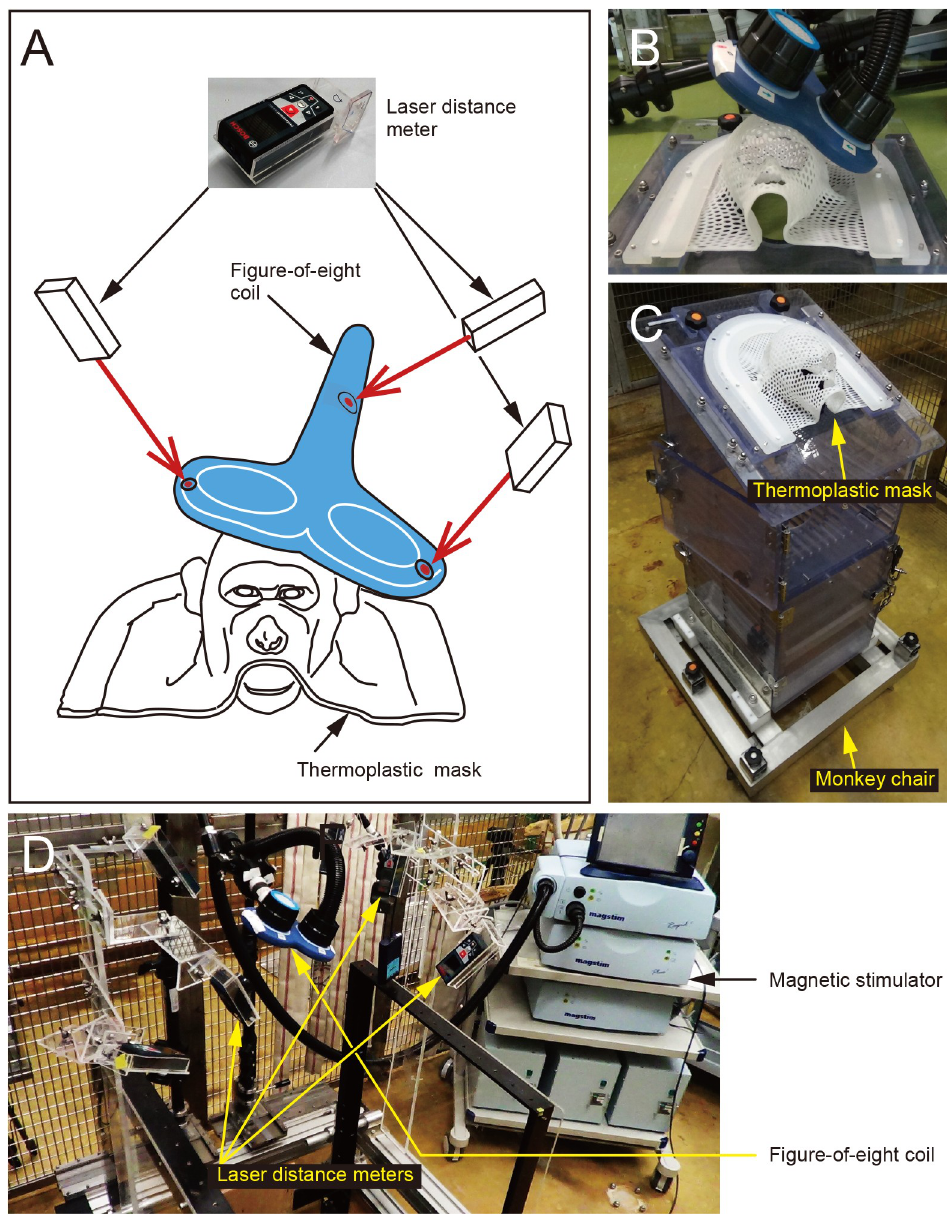
Fig 2. Setup of the newly developed rTMS system. (A) Schematic diagram of the present system for achieving constant and effective stimulation targeting the MI of an awake monkey. (B) A thermoplastic mask shaped to fit the monkey’s head is utilized to fix the monkey’s head, secure a sufficient space for a figure-of-eight coil, and contact the coil close to the scalp. (C) The thermoplastic mask is firmly screwed to the upper part of a monkey chair for restraining any head movement. (D) Three laser distance meters are positioned to measure accurate three-dimensional coordinates of the figure-of-eight coil. For details, see “Development of rTMS system” of the Results section.